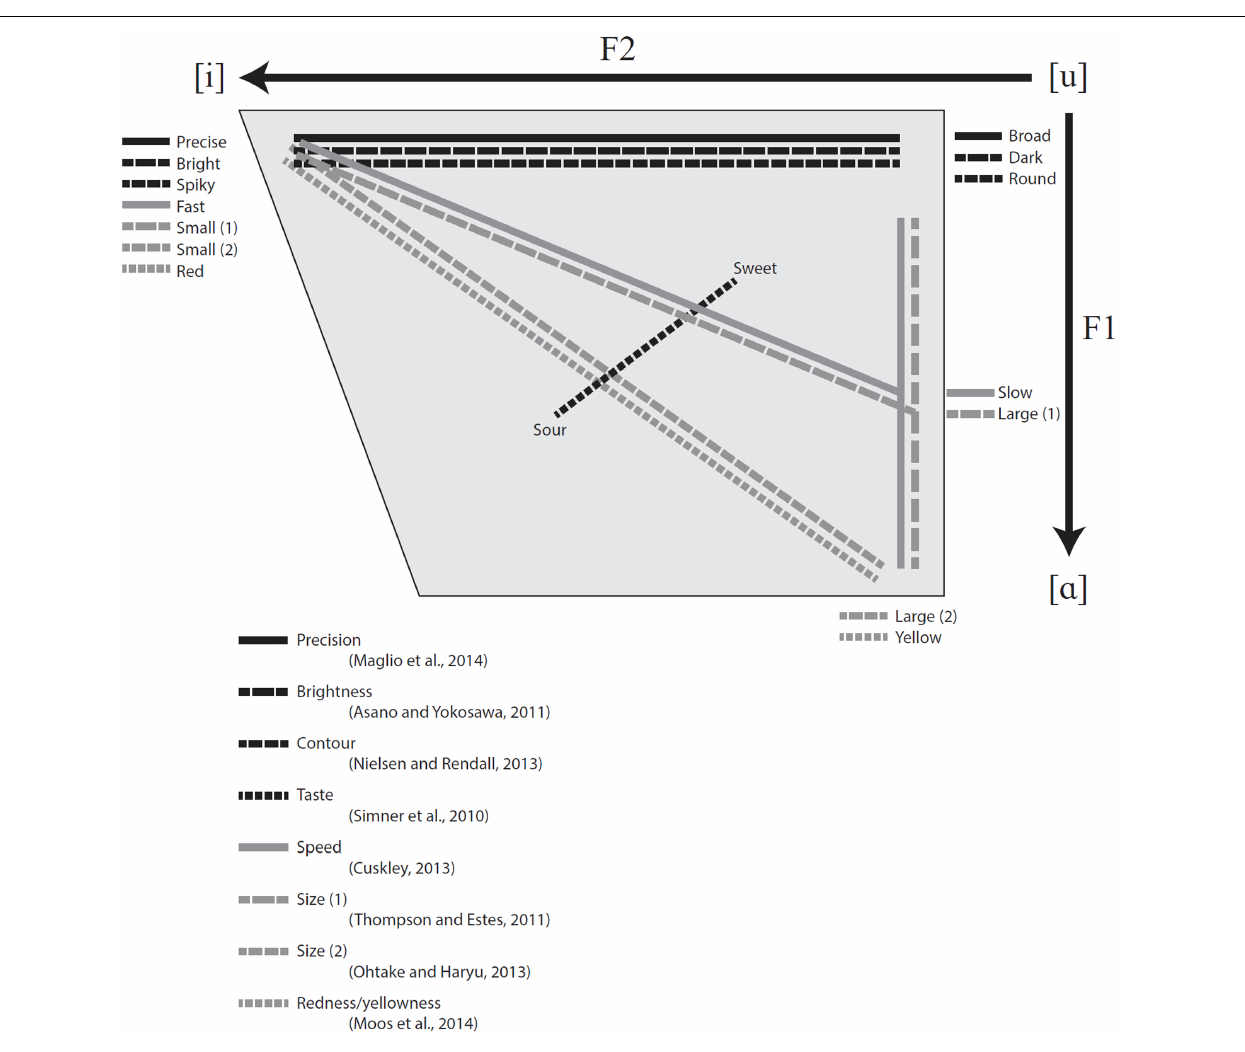
FIGURE 1 | Diagram of attested cross-modal mappings to linguistic sound represented on typical vowel